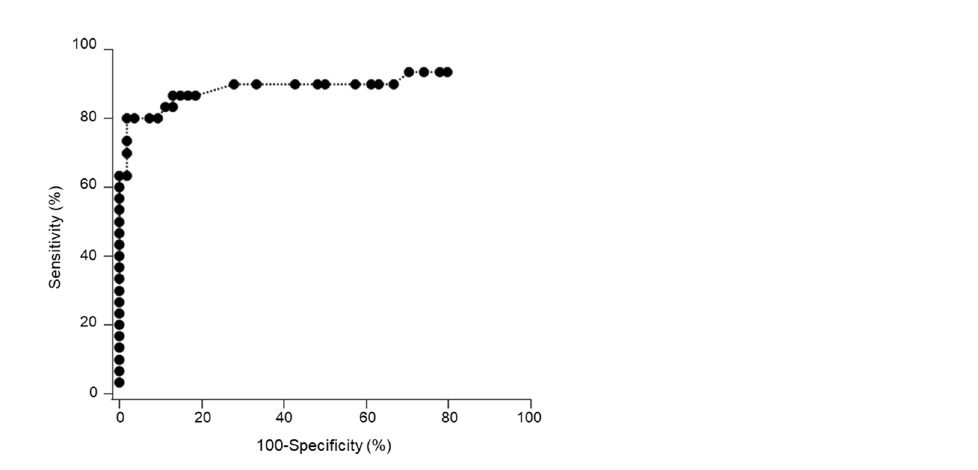
Figure 3. Receiver operating characteristic (ROC) curve analysis. An ROC curve was drawn using human samples with and without SARS-CoV-2.